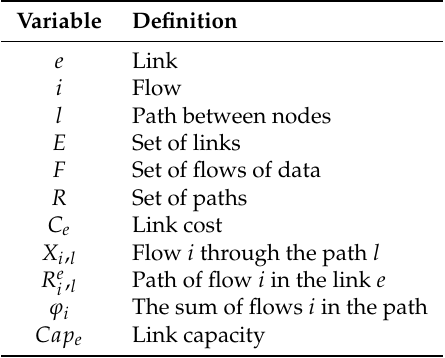
Table 2. Notations of the problem